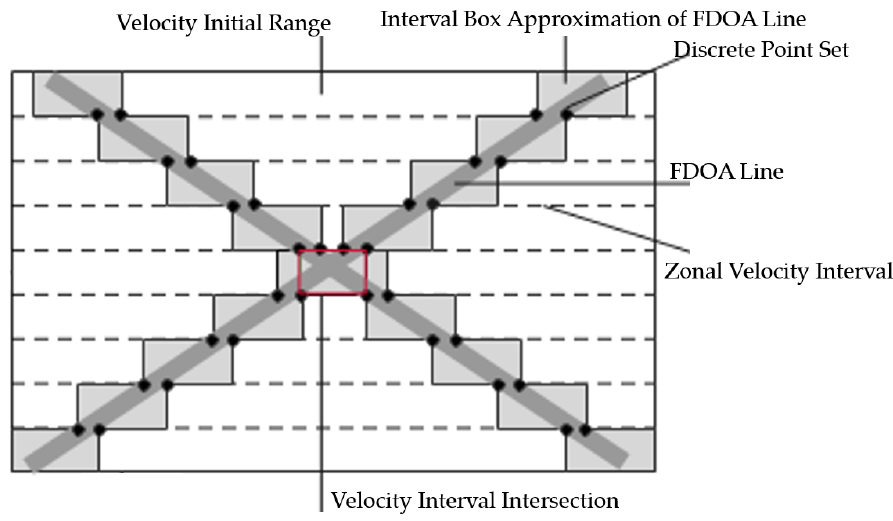
Figure 2. Interval contraction diagram.